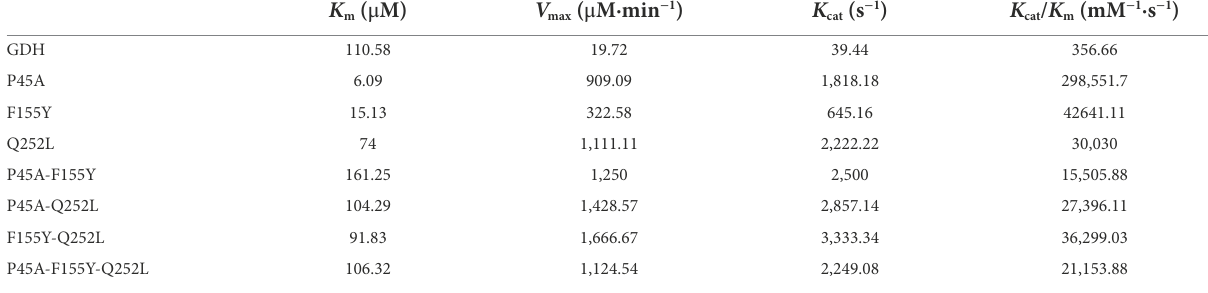
TABLE 2 Kinetic parameters of GDH